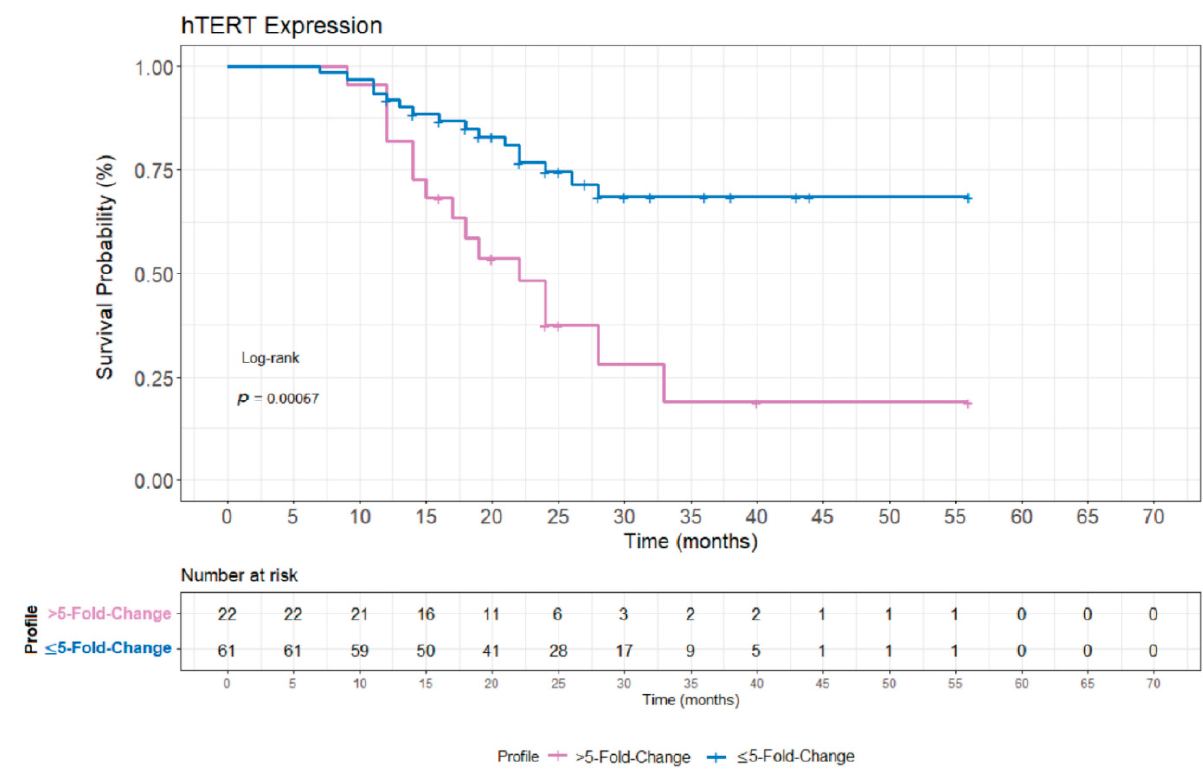
Figure 4. Comparison of survival time for patients with different levels of hTERT expression. Survival time was statistically different between patients. Patients expressing hTERT showed a significantly lower survival rate in patients ( p < 0.0001) who had higher expression levels (>5 fold-change).